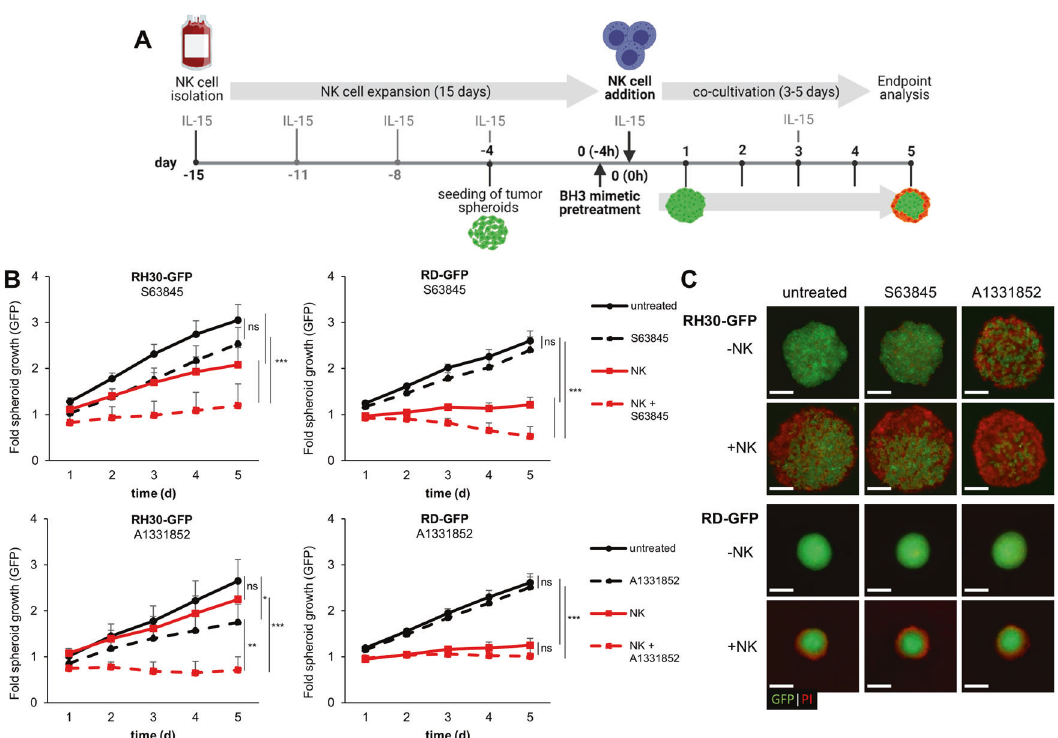
Fig. 6 BH3 mimetics increase NK cell-mediated killing of tumor spheroids. A Experimental setup of combined BH3 mimetics and NK cell treatment. B Addition of the Mcl-1 inhibitor S63845 (0.3 μ M) or the Bcl-X L inhibitor A1331852 (0.3 μ M) increases the NK cell-mediated effect (E:T ratio of 1:1) on spheroid growth inhibition. Data shown are mean + SEM ( n = 5 – 7). ns: p > 0.05, * p < 0.05, ** p < 0.01, *** p < 0.001. C Exemplary images of the combination of S63845 or A1331852 with NK cells showing increased cell death in tumor spheroids, indicated by PI counterstaining of GFP fl uorescent RMS spheroids after 72 h of NK cell co-culture. Scale bar equals to 500 μ